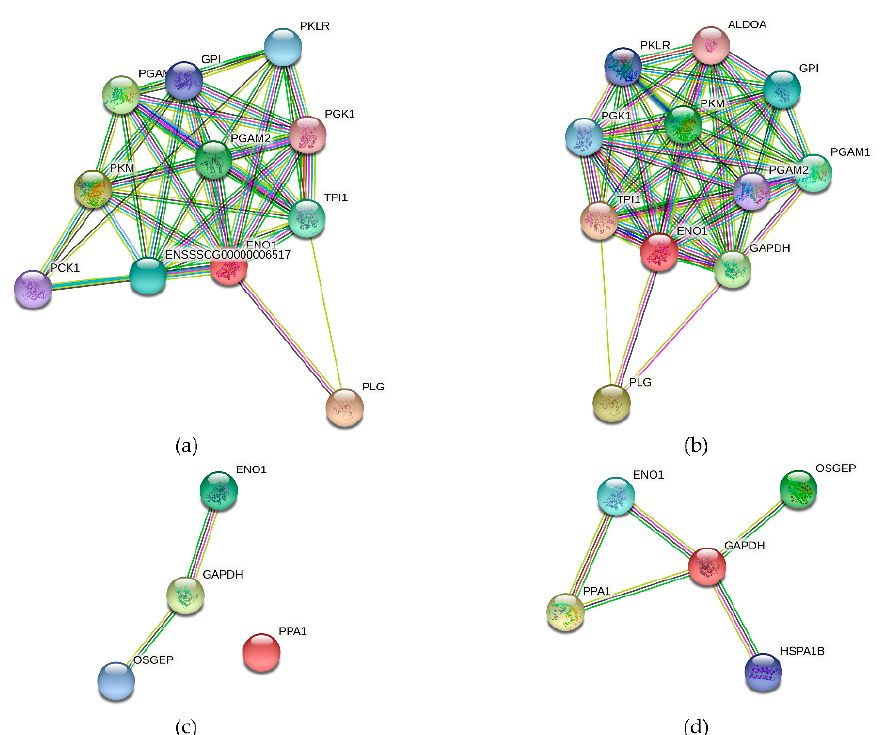
Figure 10. The networks of interactions among alpha-enolase (ENO1) and other proteins (no clus- tering). Each node represents all the proteins produced by a single, protein-coding gene locus. An association means that the proteins most likely collaborate to perform a common function. The dots and lines are defined in the STRING manual. ( a ) An alpha-enolase interaction network based on Sus scrofa . ( b ) An alpha-enolase interaction network based on Homo sapiens . ( c ) An interaction network for alpha-enolase (ENO1), GAPDH, and OSGEP in Sus scrofa . ( d ) An interaction network for alpha- enolase (ENO1), GAPDH, OSGEP, PPA1, and HSPA1 in Homo sapiens .